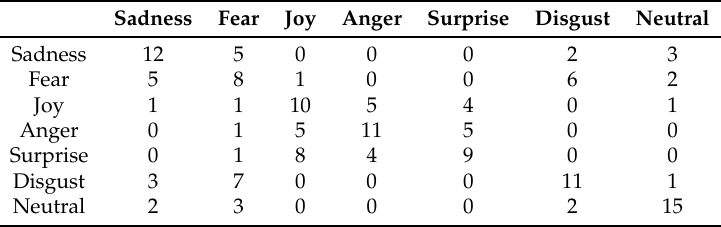
Table A8. P8 actor confusion matrix from the RekEmozio dataset in the second phase.